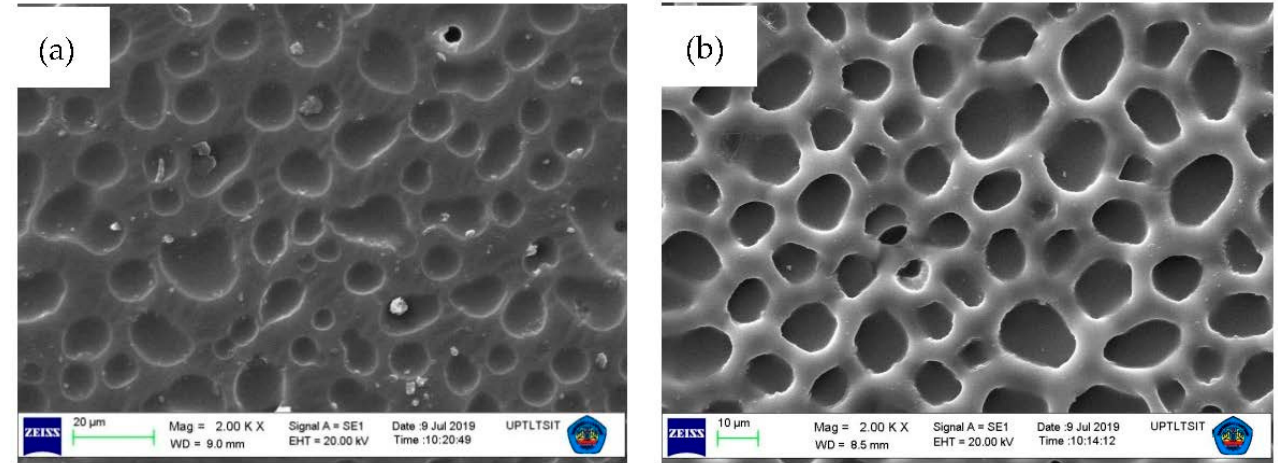
Figure 10. Characterization of SEM PIM membranes after transport with magnification of 2000 × ( a ) before and ( b ) after transport